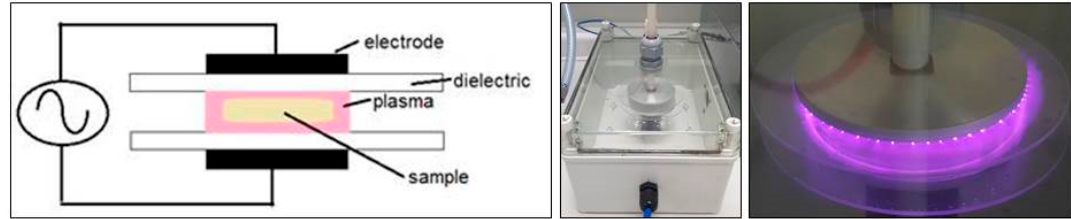
Figure 1. Dielectric Barrier Discharge (DBD) electrode: graphical illustration ( left ); set-up used in this study ( middle ); and close-up of the discharge ( right ).